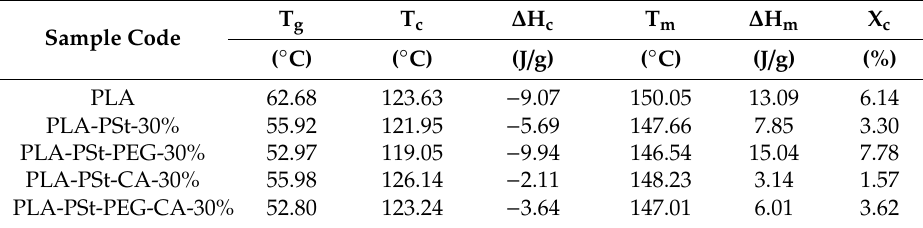
Table 3. Thermal properties of the